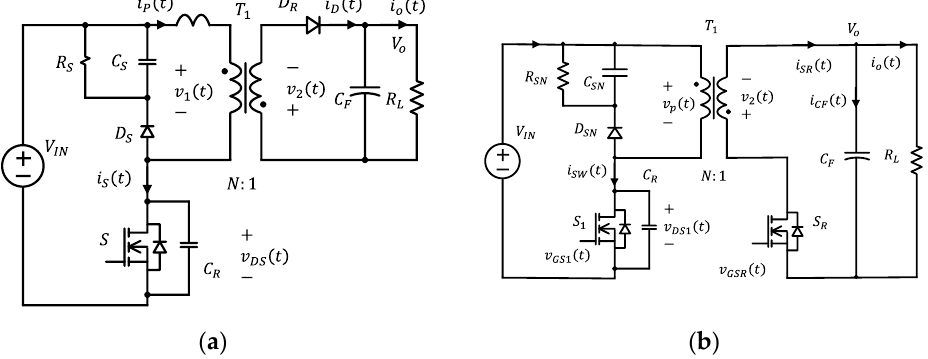
Figure 1. Basic circuit of QR flyback converter with RCD snubber: ( a ) QR flyback converter with diode rectifier; ( b ) QR flyback converter with synchronous rectifier.